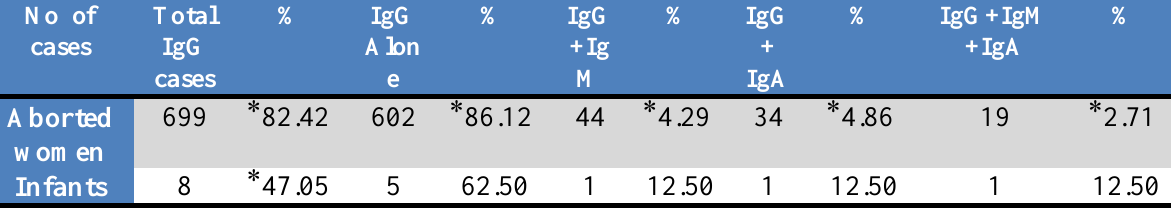
Table (4).Detection of IgG anti Toxoplasma gondii in association with IgM and IgA in aborted women and infants